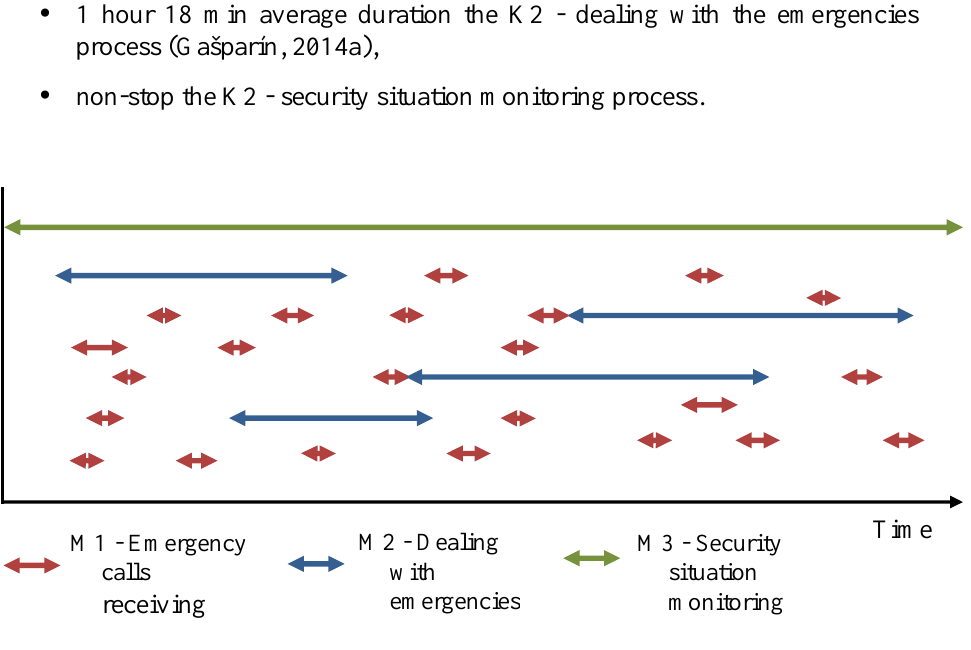
Figure 6 – The succession and concurrence of the key